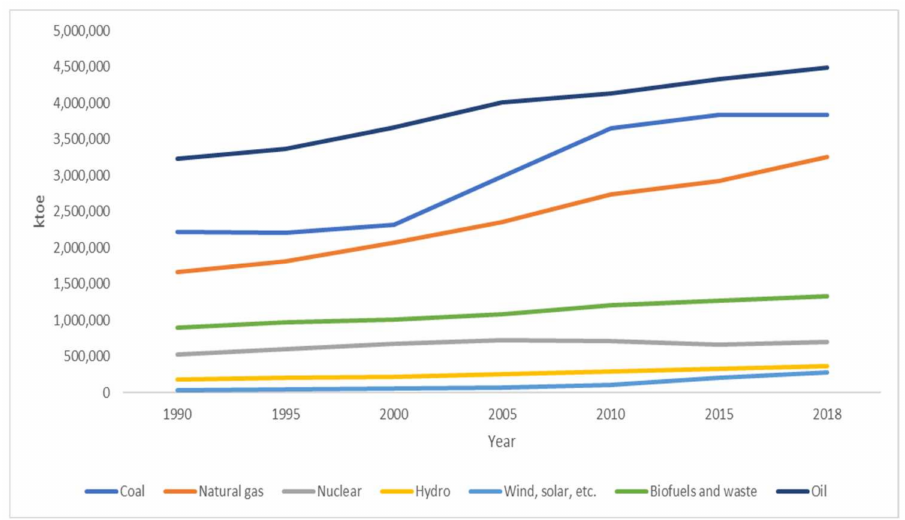
Figure 2. Total energy supply by source in the world (1990–2018). Source: own results based on